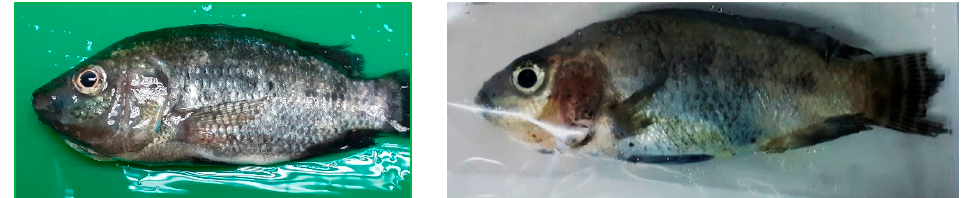
Figure 3. Clinical findings (patches and dark-colored skin ( left ), fin rot ( right ) during the challenge with Aeromonas hydrophila.